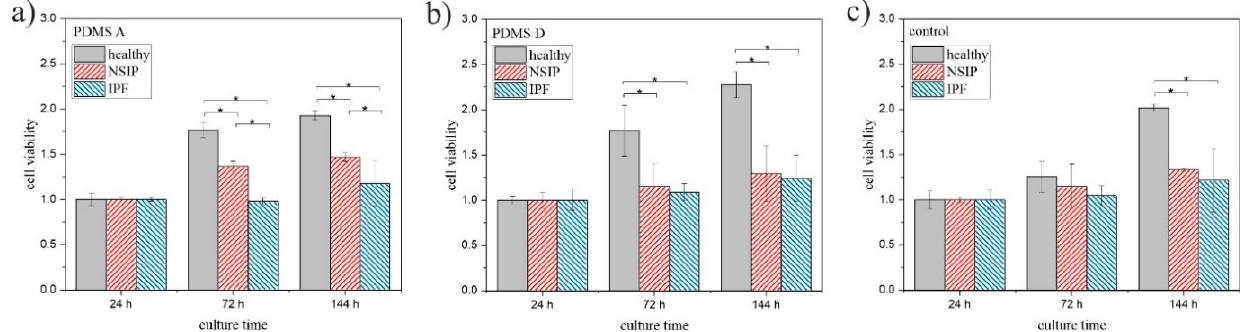
Figure 6. MTS values determined for healthy (gray), NSIP- (red), and IPF-derived (blue) fibroblasts cultured on PMDS A ( a ), PDMS D ( b ), and control sample (glass, ( c )). Statistical significance was achieved for p < 0.01 (*).